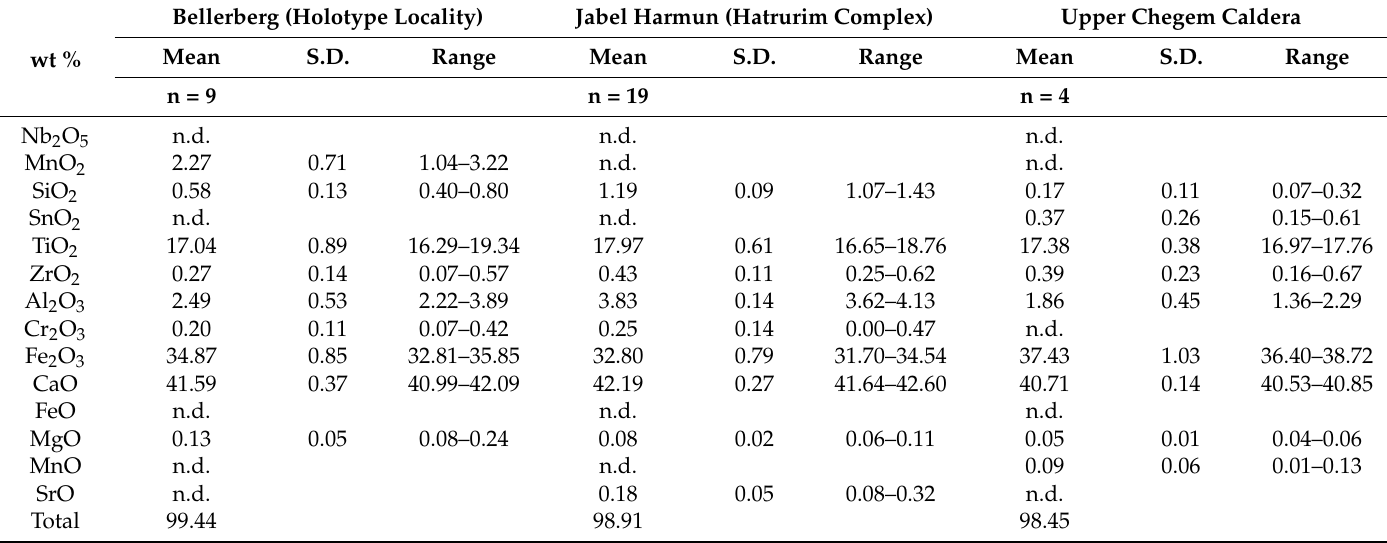
Table 3. The representative chemical composition of sharyginite from different